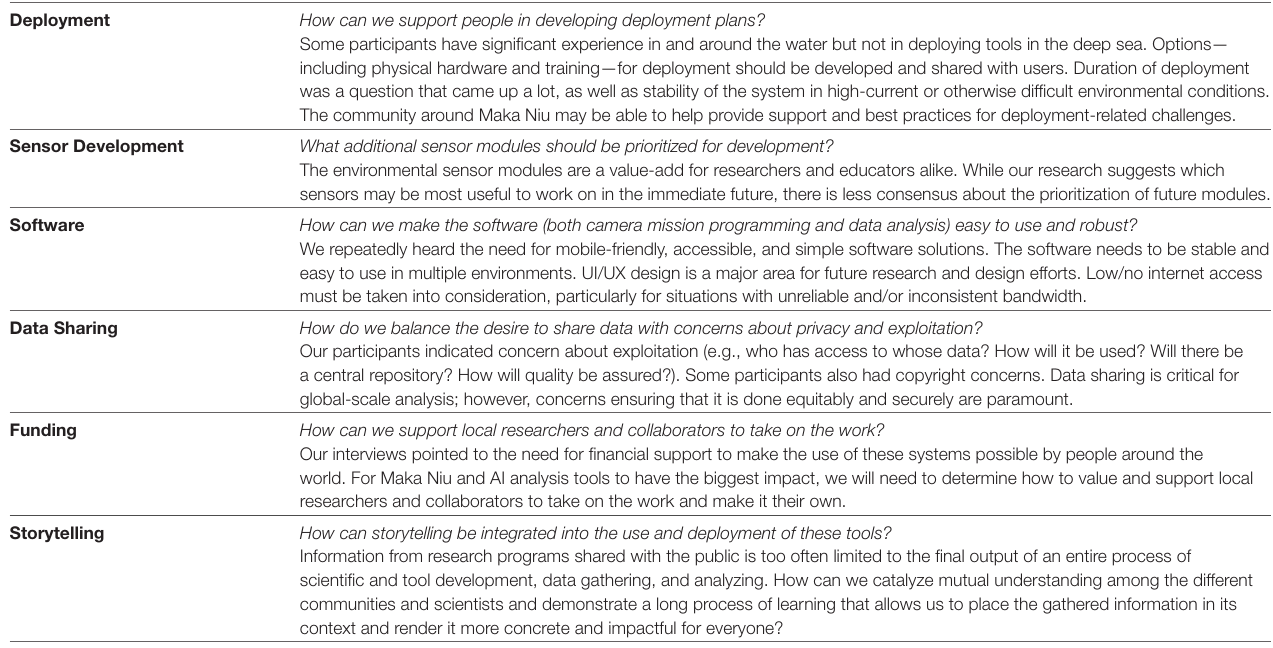
TABLE 4 | Open design questions and